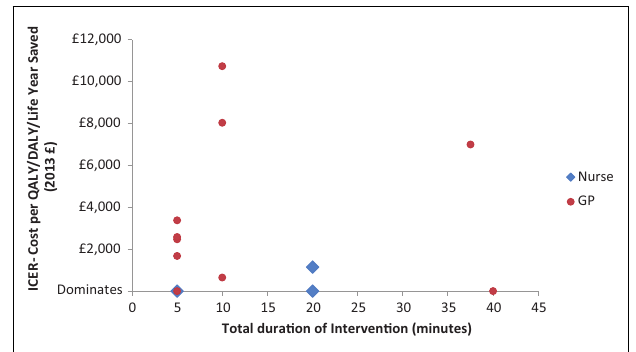
FIGURE 2 | Cost-effectiveness of SBI programs by SBI duration and delivery staff